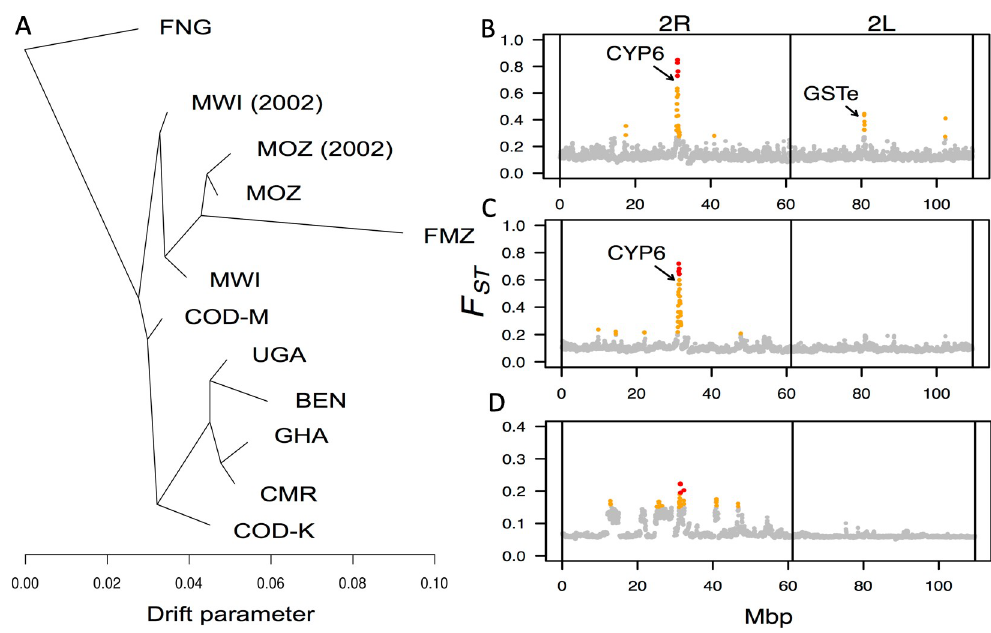
Fig 2. Genetic differentiation between Anopheles funestus populations. (A) TreeMix phylogeny showing the relationship between all An . funestus populations (using PoolSeq data). The drift parameter on the x-axis reflects the amount of genetic drift among populations. The tree was created from all genome-wide SNPs passing filters, without migration edges inferred, and ten iterations of TreeMix produced identical topologies. (B) Genetic differentiation (fixation index F ST ) on chromosome 2 between An . funestus populations from Benin and Mozambique. Each point represents F sliding window of 50 kb, moving in 25 kb steps (using PoolSeq data). The highest 1% and 0.1% of F orange and red, respectively. Peaks of genetic differentiation at the CYP6 cluster (under selection in both populations) and the GSTe cluster (under selection in Benin only) are indicated. (C) Genetic differentiation (fixation index F chromosome 2 between An . funestus populations from Uganda and the Democratic Republic of Congo (Kinshasa). A peak of genetic differentiation at the CYP6 cluster (under selection in both populations) is indicated. (D) Genetic differentiation (fixation index F ST ) on chromosome 2 between An . funestus populations from Ghana and Cameroon, showing around 7 extended regions of elevated divergence on arm 2R.